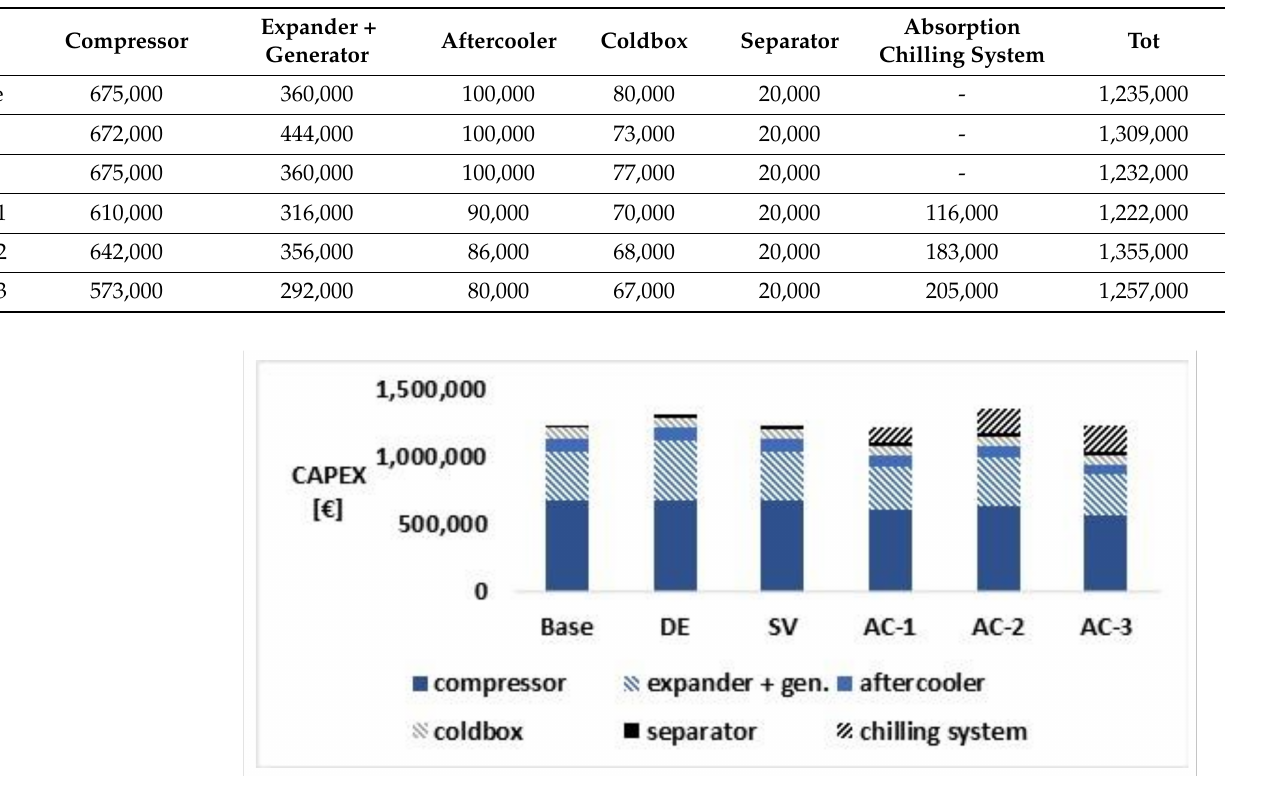
Figure 18. CAPEX of the various cases. Different colors refer to different elements of the